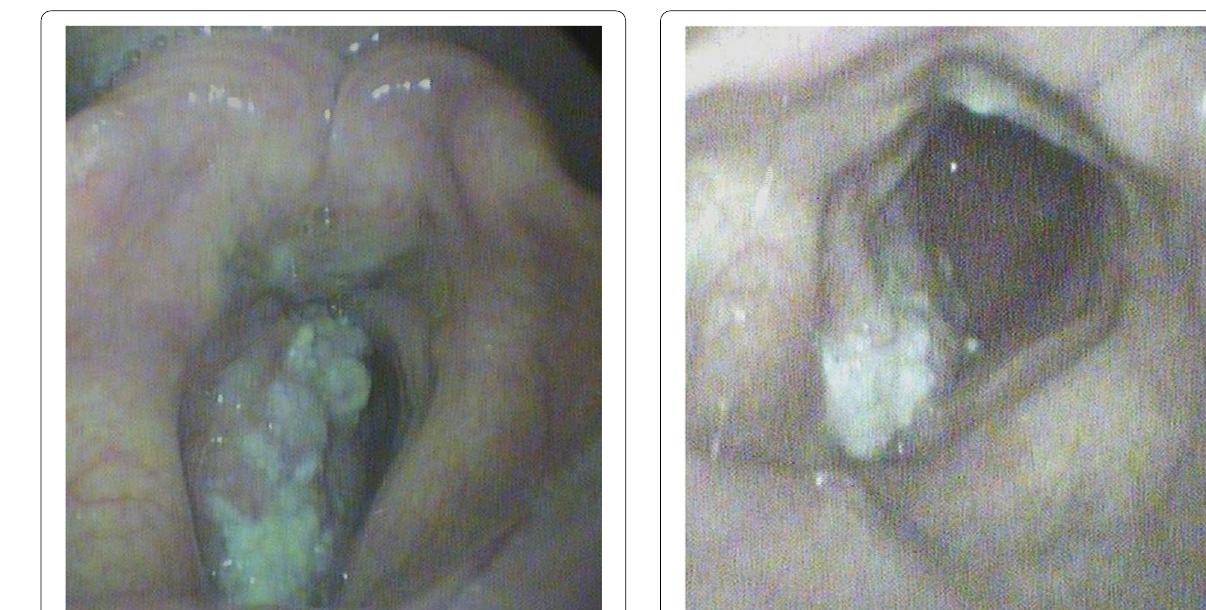
Fig. 2 Decrease in the growth over the right vocal